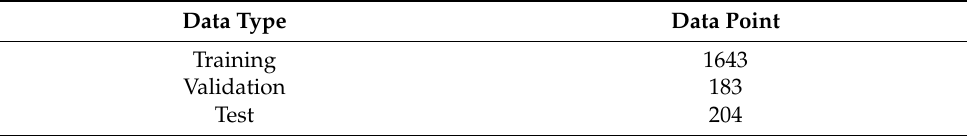
Table 3. Splitting of dataset for training, validation, and